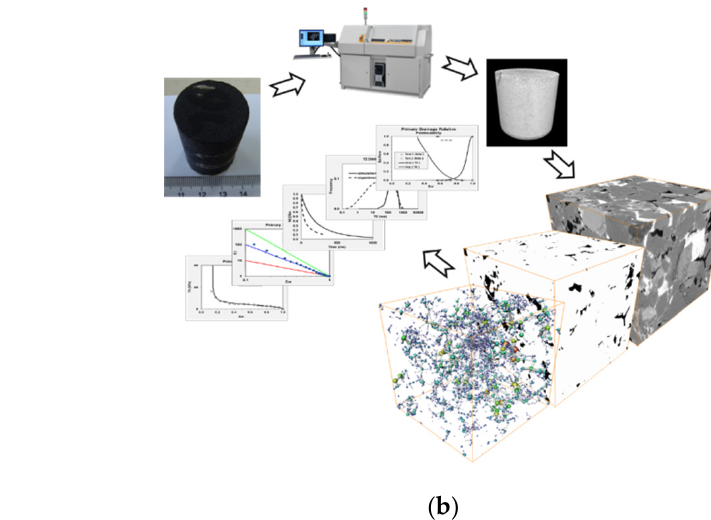
Figure 3. ( a ) Layout of the X ‐ ray CT scan imaging; ( b ) workflow chart analysis.